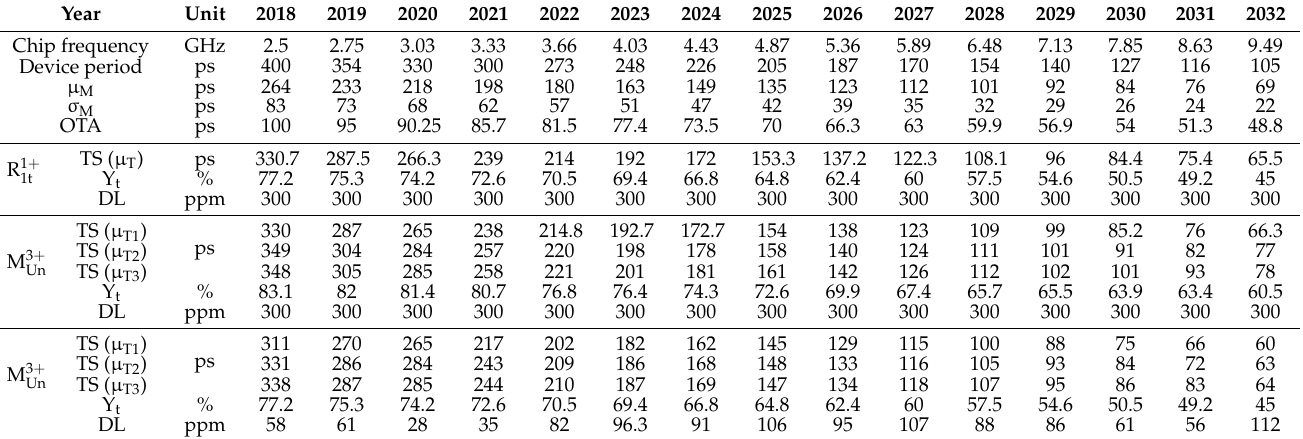
Figure 6. Methods used to estimate the test yield in future products. Table 4. Comparison of yields and qualities obtained by two test methods (IRDS